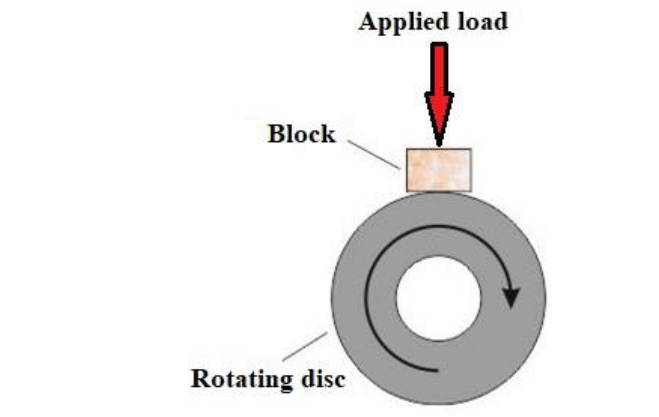
Table 2. Roughness parameters of tested materials in µ